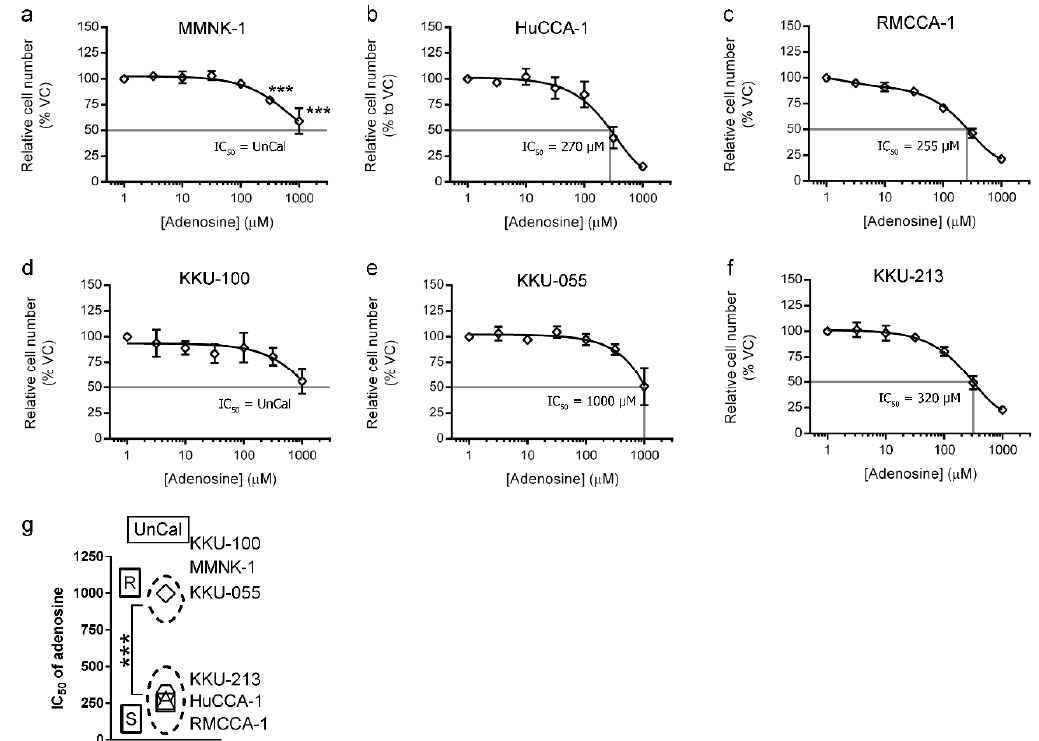
Figure 1. Four-day cell viability MTT assay was used to examine adenosine sensitivity on cholangiocarcinoma (CCA) and immortalized cholangiocyte (imCho) cell lines. ( a–f ) Adenosine inhibited CCA and imCho cell growth in a dose-dependent manner. ( g ) Cell lines were classified into adenosine-sensitive group, adenosine-resistant group and unresponsive or uncalculatable group, of which IC 50 was uncalculatable. Statistical analysis in ( g ) was Student’s t -test. VC; vehicle control, S; sensitive, R; resistant, UnCal; uncalculatable, *** p < 0.001. All experiments were performed using at least three biological replicates with internal triplicate. Graphs are plotted as mean ± SD. Table 1. IC 50 and pIC 50 of the adenosine on cholangiocarcinoma (CCA) and immortalized cholangiocyte (imCho) cell lines. UnCal; uncalculatable.